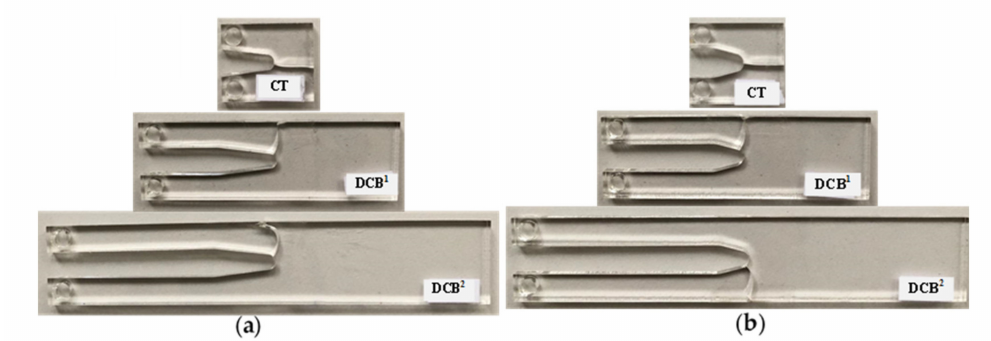
Figure 12. CT, DCB 1 and DCB 2 blunt V-notched specimens fractured under mode I loading condition: ( a ) γ = 15 ◦ , ρ = 2.5 mm; ( b ) γ = 30 ◦ , ρ = 3.0